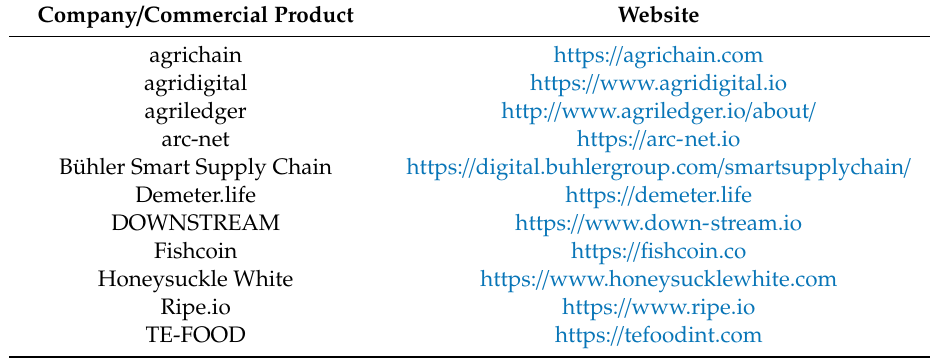
Table 4. Companies and websites which promote blockchain solutions for agriculture supply